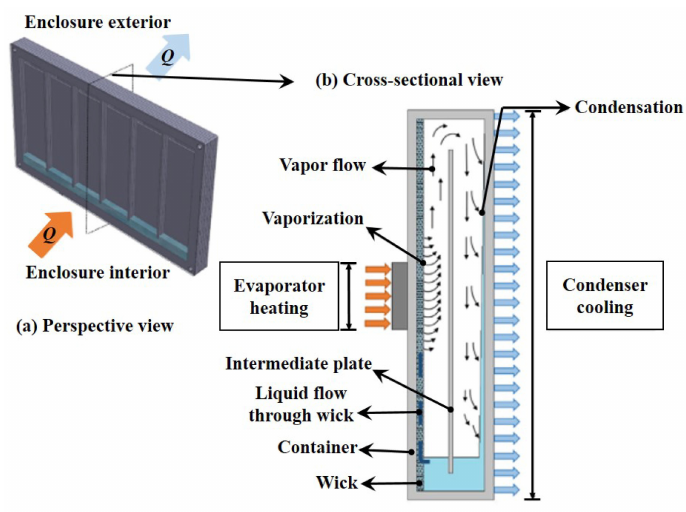
Figure 13. A novel flat thermosyphon and its working principle